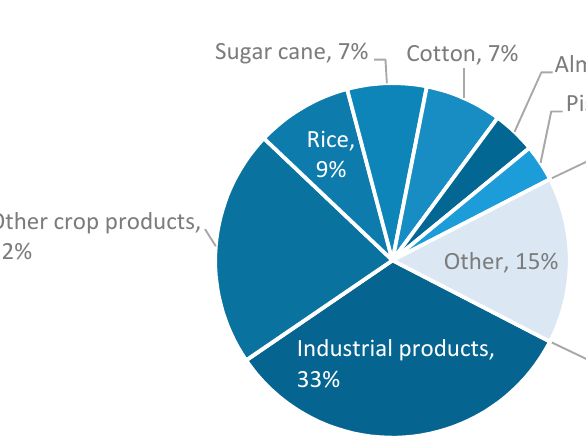
South Africa) (Figure